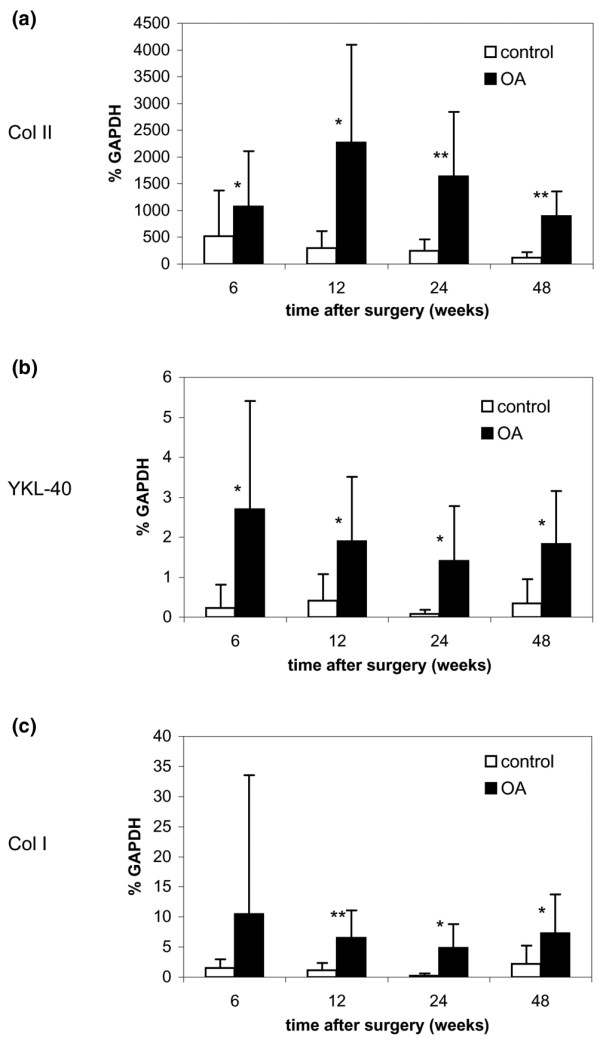
(a) Collagen type (col) II, (b) YKL-40 and (c) col I expression in cartilage of experimental osteoarthritis (OA) at different times after surgery. Shown are the mean relative expression levels of mRNA summarized for lateral and medial tibial plateau. * P < 0.05, ** P < 0.001.